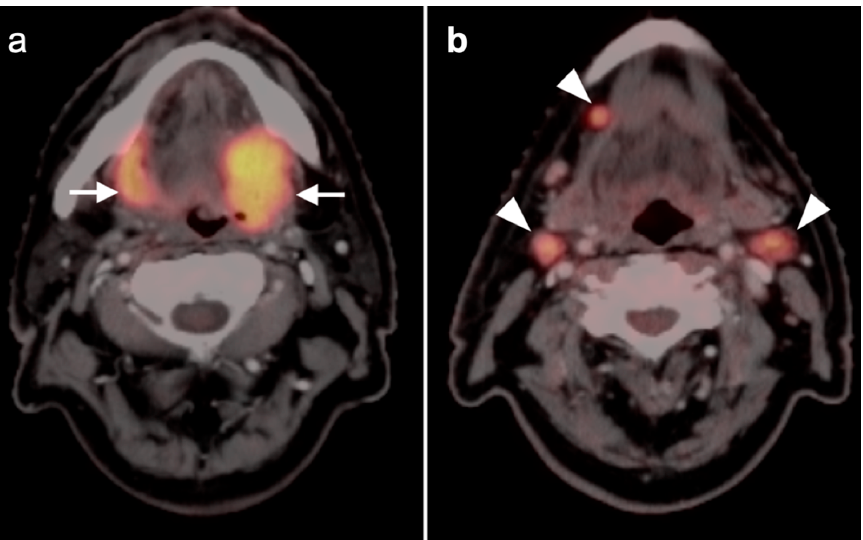
Figure 14. Bilateral oral cavity squamous cell carcinoma of the tongue. ( a ) Right oral tongue squamous cell carcinoma (white arrow) and left glossotonsillar primary with spread into the oral tongue (white arrow); ( b ) There is spread to rounded hypermetabolic right anterior submandibular and bilateral level 2A cervical nodes (white